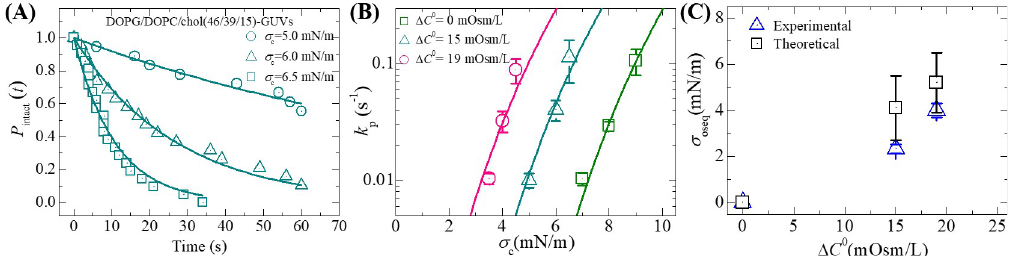
Fig 3. Constant electric tension-dependent rupture of DOPG/DOPC/chol (46/39/15)-GUVs under different osmotic pressures. (A) The time course of the fraction of intact DOPG/DOPC/chol (46/39/15)-GUVs at tensions σ c = 6.5, 6.0 and 5.0 mN/m. The solid lines represent the best-fitted single exponential decay function of Eq (5). (B) The σ c dependent k p value for DOPG/DOPC/chol (46/39/15)-GUVs under the osmolarity difference between the inside and outside of GUVs, Δ C 0 = 0 (green open square), Δ C 0 = 15 mOsm/L (cyan open triangle) and Δ C 0 = 19 mOsm/L (pink open circle). Average values with standard deviations of k p at σ c were determined for 2–3 independent experiments, each with 15–24 GUVs, for each value of σ c . The solid (green, cyan and pink) lines were the best fit theoretical curves corresponding to Eq (3) using line tension Γ = 12.9 pN, B = 2.14 mN/m and A F = 8.4 × 10 5 m 2 s − 1 J − 1 . The cyan line and the pink line correspond to the theoretical Eq (3) using σ t = σ c + 2.3 mN/m and σ t = σ c + 4.0 mN/m, respectively. (C) The Δ C 0 dependent membrane tension ( σ oseq ) (experimental and theoretical). Experimental values were determined by analyzing the constant electric tension-induced rupture of GUVs. Their mean values with standard deviations are shown.